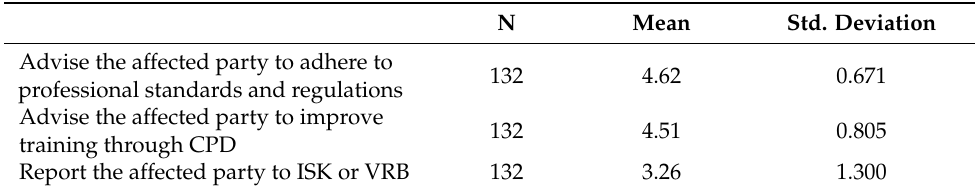
Table 13. Valuers’ response to valuer misconduct.